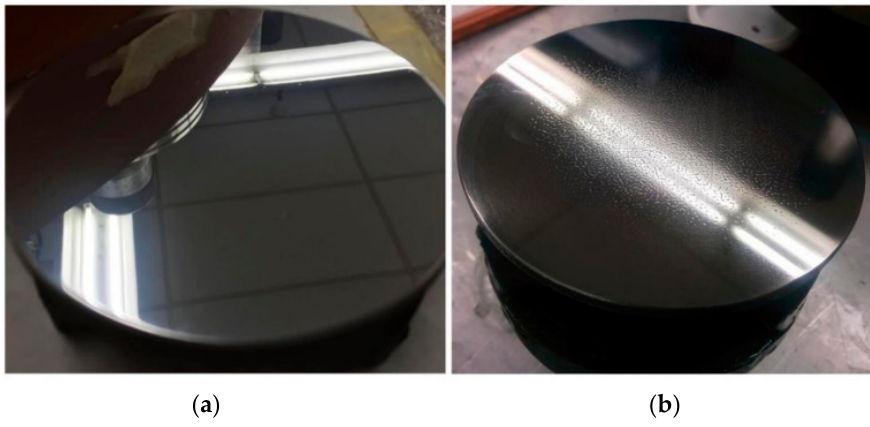
Figure 20. ( a ) Final Al mirror surface finish; ( b ) Final Ti mirror surface finish [30].